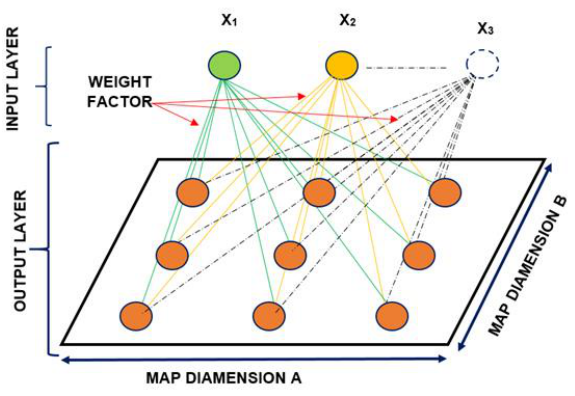
Figure 4. The scheme of the Kohonen artificial neural network (own elaboration based on [78]).